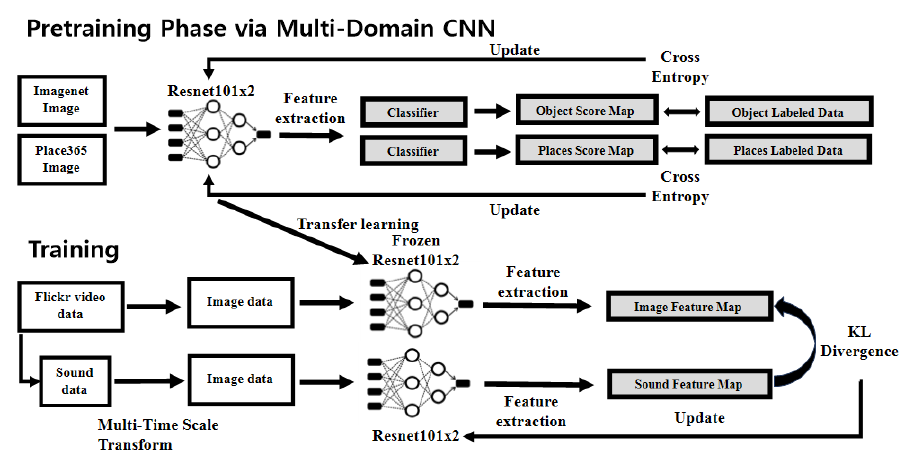
Figure 2. The training phase was divided into a pre-training phase and a training phase. This learning framework is similar to that of the soundnet framework; however, the pre-trained model with features shared via a multi-domain CNN, audio feature extraction via multi-time-scale transform, and weakly supervised learning via mutual learning are advantages of our